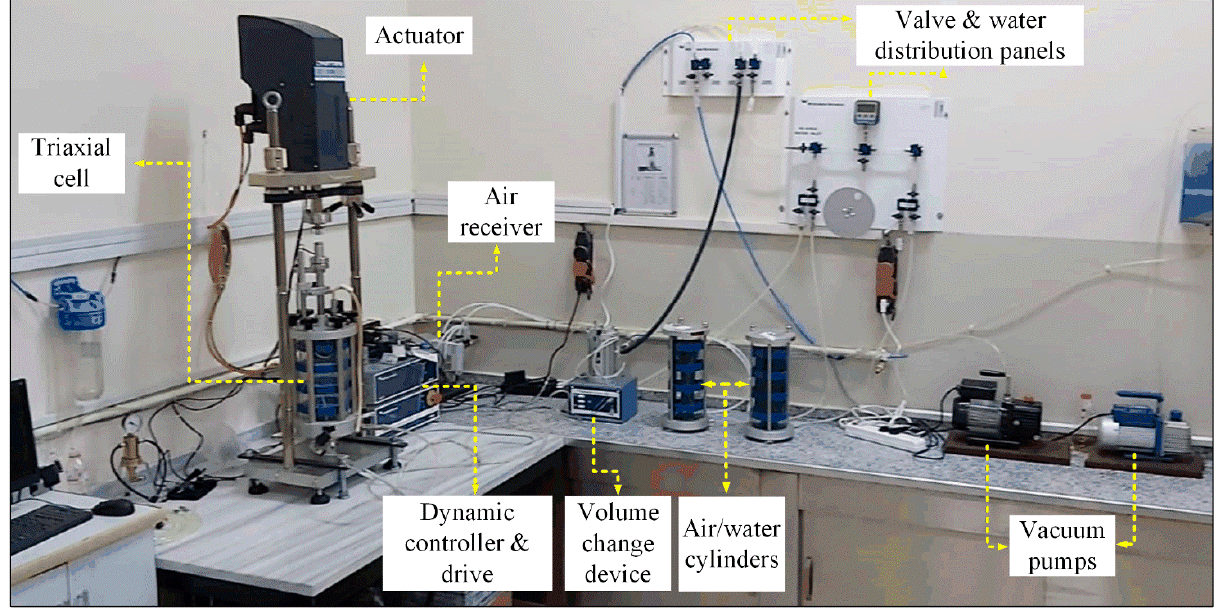
Figure 1. Dynamic triaxial test system at Mus Alparslan University.